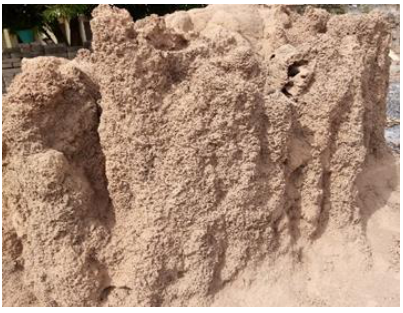
Figure 1: Termite mound as the source of Termitaria clay.